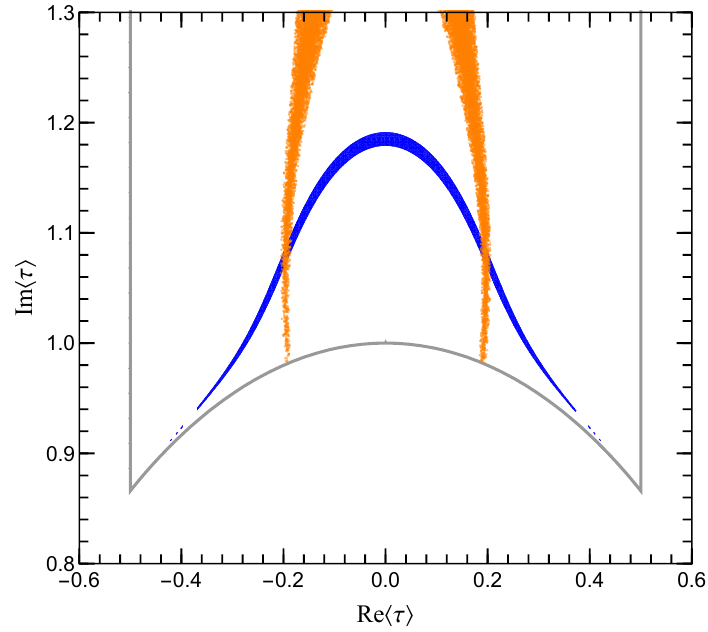
Figure 1 . The region of modulus τ compatible with experimental data, where the gray line is the boundary of the fundamental domain. The blue region represents the feasible range of h τ i compatible with the data ∆ m 2 of the neutrino mass squared difference [89]. The orange / ∆ m 2 21 31 area denotes the viable region of h τ i limited only by the measured values of the charged lepton mass ratios and the reactor mixing angle θ [89, 13